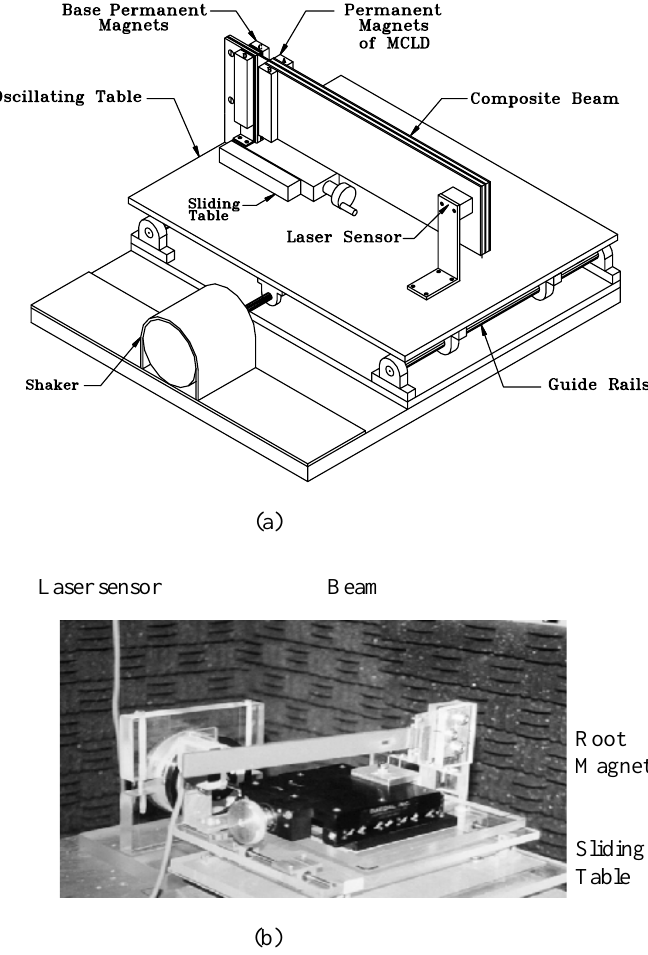
Fig. 4. The experimental set-up (a) schematic drawing, (b)